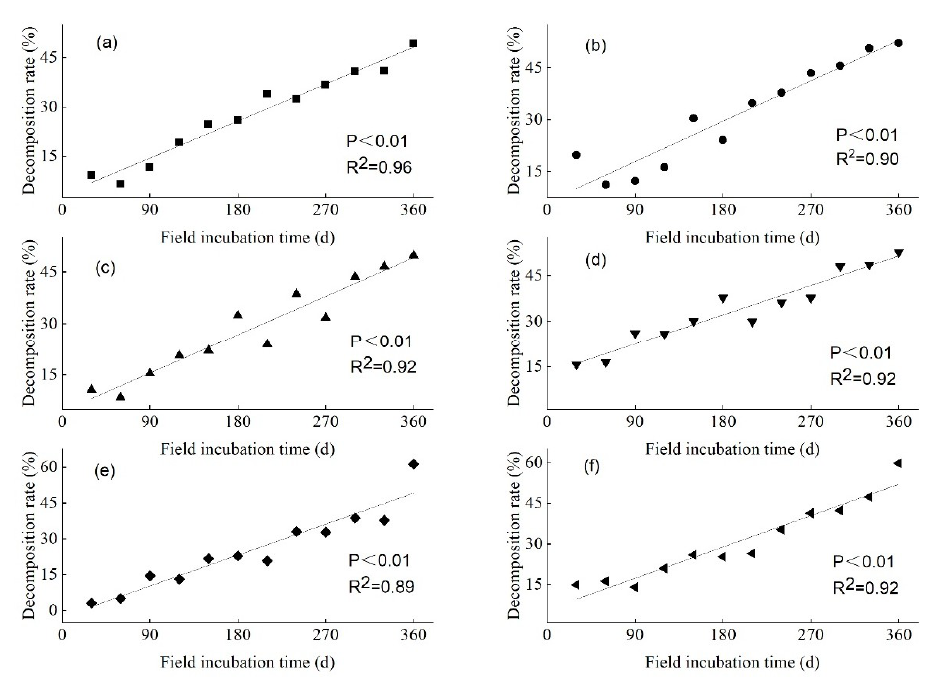
Figure 4. Relationship between the length of field incubation with the decomposition rate of the mangrove litter for ( a ) the branch of Heritiera littoralis ; ( b ) the leaf of Heritiera littoralis ; ( c ) the branch of Thespesia populnea ; ( d ) the leaf of Thespesia populnea ; ( e ) the branch of Kandelia obovata ; and ( f ) the leaf of Kandelia obovata .